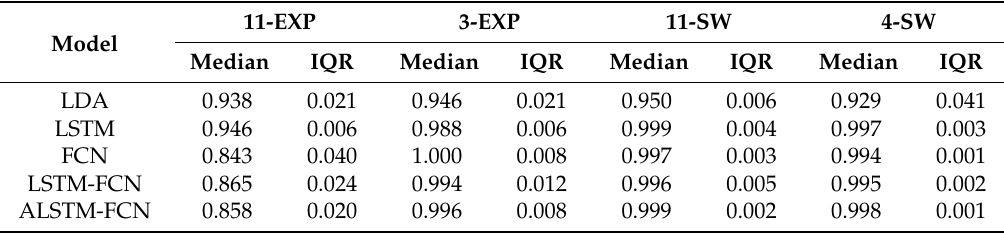
Figure 3. Receiver operating characteristic (ROC) curves and ROC area under the curve (ROCAUC) summary boxplots. ( A ) Representative micro-average ROC curves for each algorithm tested on each dataset in the study. ( B ) AUCs calculated from micro-average ROC curves were plotted from repeated ( ≥ 25) training-test splits for each algorithm. Table 2. Receiver operating characteristic area under the curve (ROCAUC) summary.